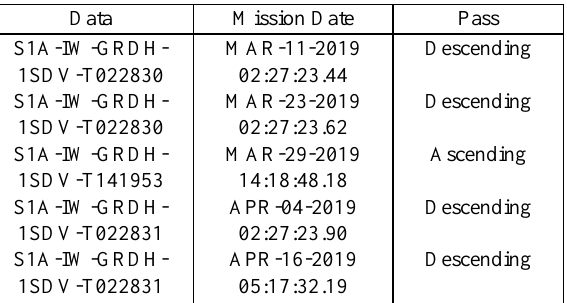
Table 1. Sentinel-1 data used for the study area Raw satellite images were downloaded, required to pre- processing such as Atmospheric correction, Calibration, Radiometric correction, Thermal noise removal, Terrain correction. We used (SNAP V.6) for applying this pre- processing.